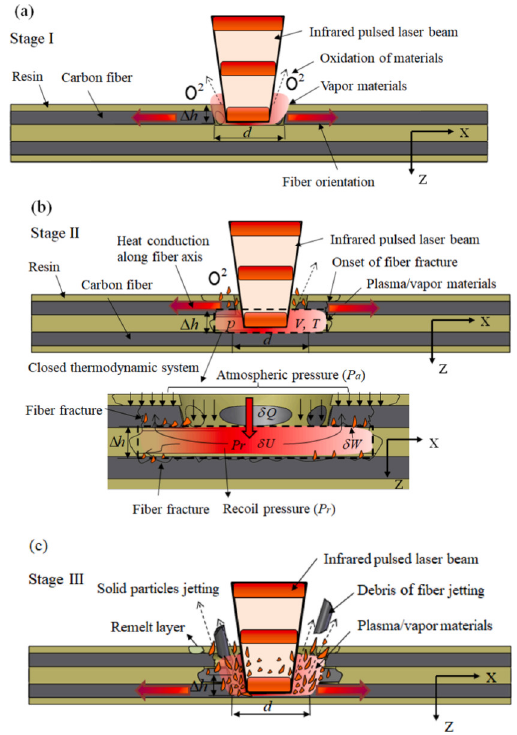
Figure 3. Schematic diagram of material removal for different stages in pulsed-laser machining of CFRP composites: ( a ) stage I; ( b ) stage II; ( c ) stage III [36].